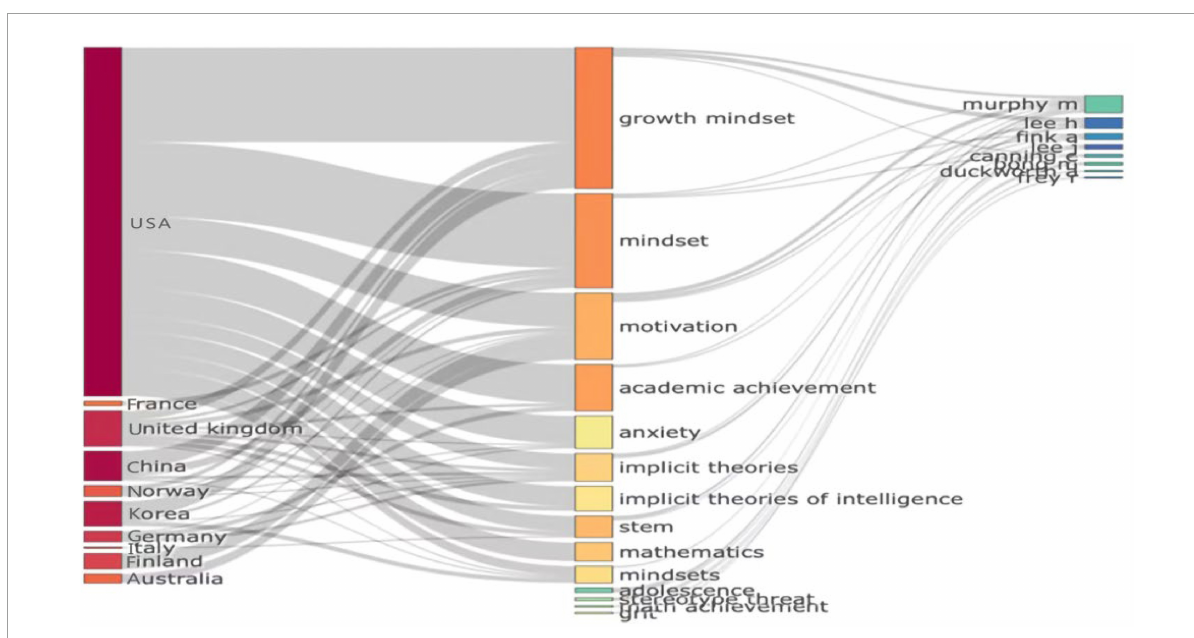
from 2012 to 2020, of which 9 are in the US and 1 is in